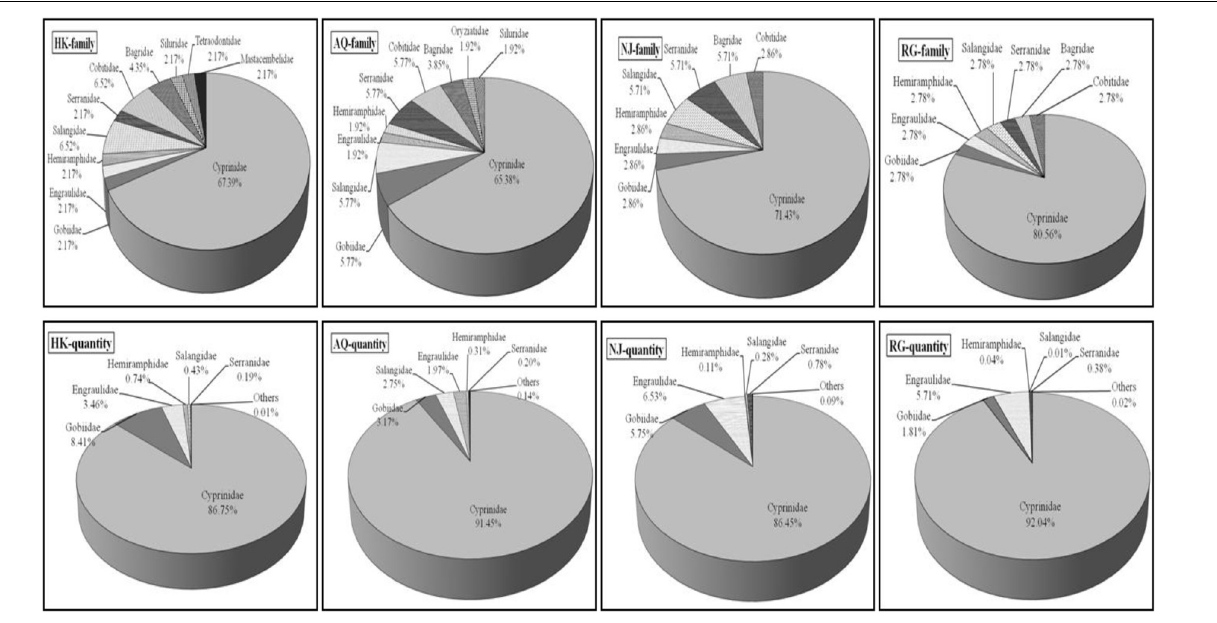
greater than that at the M site. Interestingly, the highest density of ichthyoplankton at the R site appeared earlier than that at the L and M